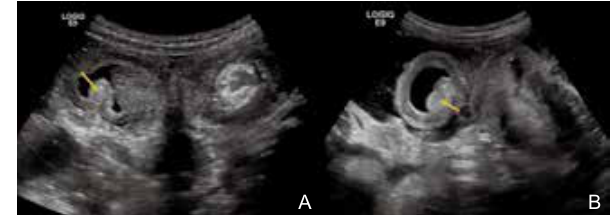
Figure 6 The ultrasonic examination of a boy (age: 5 years, 10 months) boy showing intussusception secondary to Burkitt lymphoma localized at the ileocecum, which was confirmed by surgery. (A) The long axis showing the “sleeve sign”, the neck of the intussusception showing lymphoma with hypoechoic masses (arrow); (B) CDFI revealed ample blood flow signals within lymphoma (arrow); (C) Lymphoma is located at the ileocecum after water enema, with masses (arrow) protruding into the intestinal lumen; (D) CDFI revealed ample blood flow signals within lymphoma.